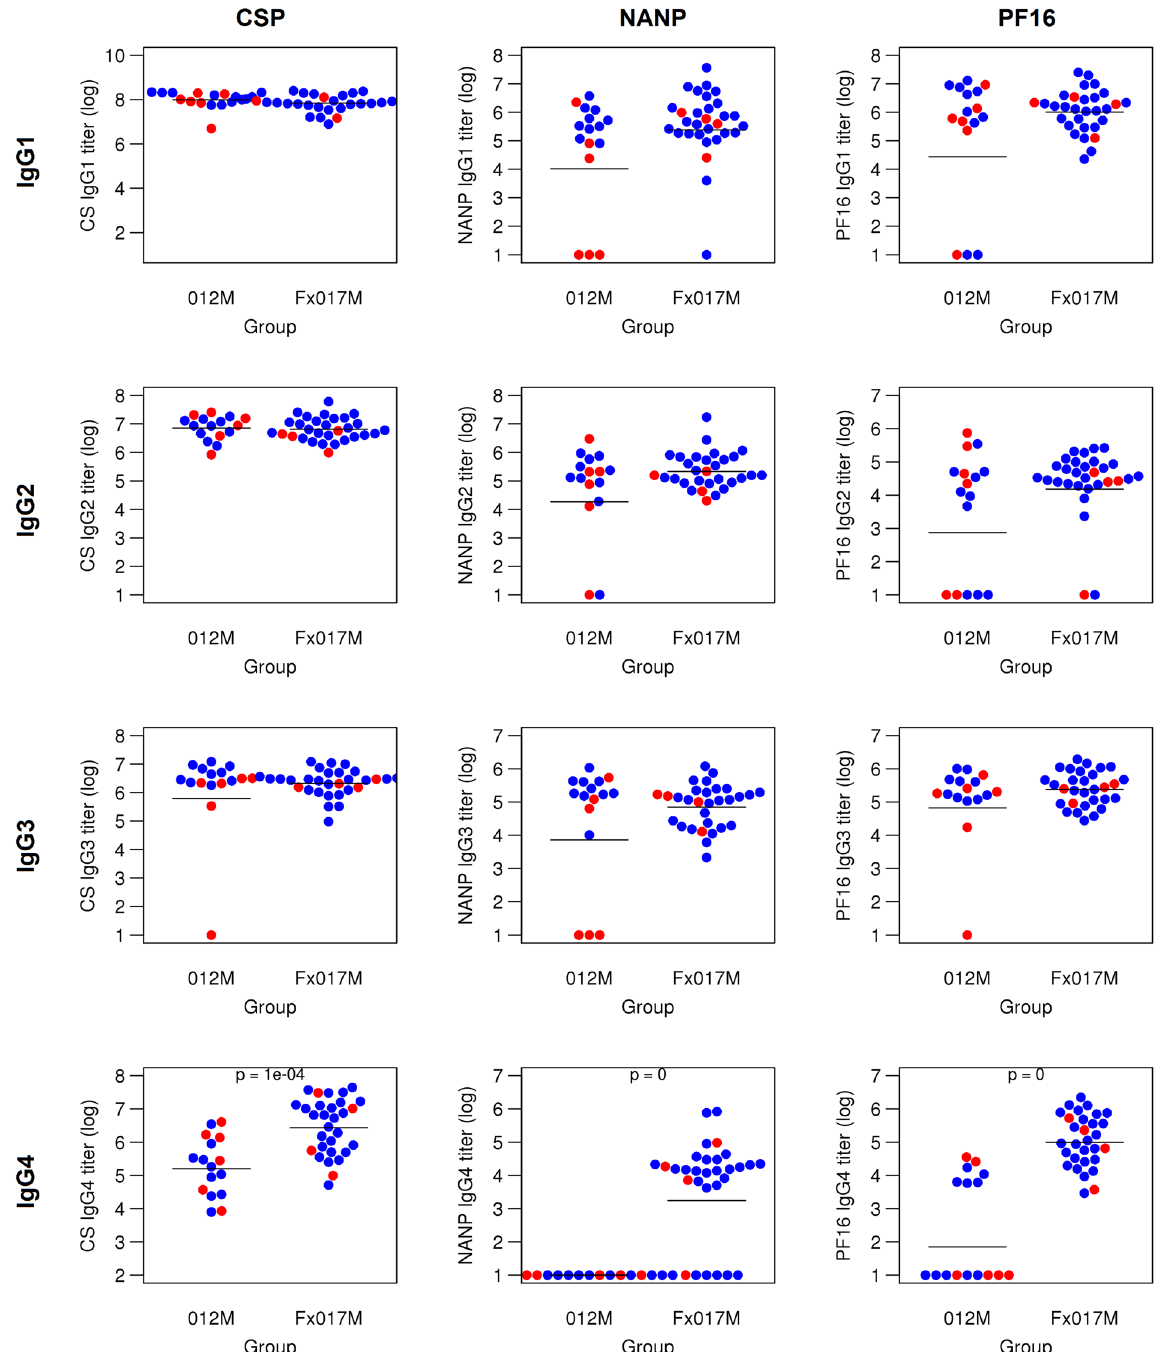
Figure 3. IgG subclass titers for 012M and Fx017M cohorts. Antibody titers for IgG1, IgG2, IgG3, and IgG4 for the 012M and Fx017M cohorts against three CSP test antigens: full-length recombinant CSP (left column), NANP repeat region peptide (middle column), and C-terminal PF16 peptide (right column). Protected and non-protected subjects are colored in blue and red,